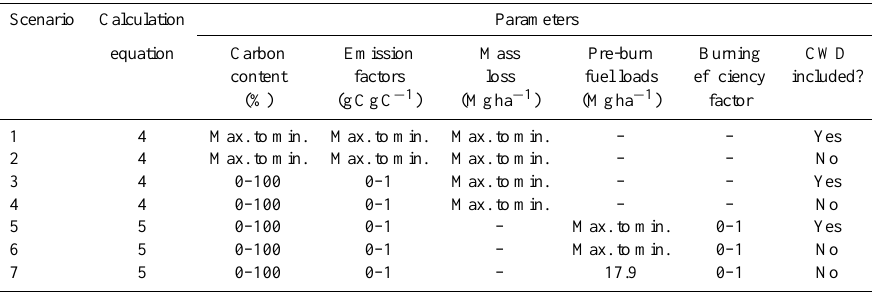
Table 1. Summary of parameters and range of values used to calculate emission estimates for seven different scenarios by Monte Carlo simulation. Max. to min. refers to the maximum and minimum values recorded for each fuel type and site. CWD is coarse woody debris. See text for further details of the equations used.